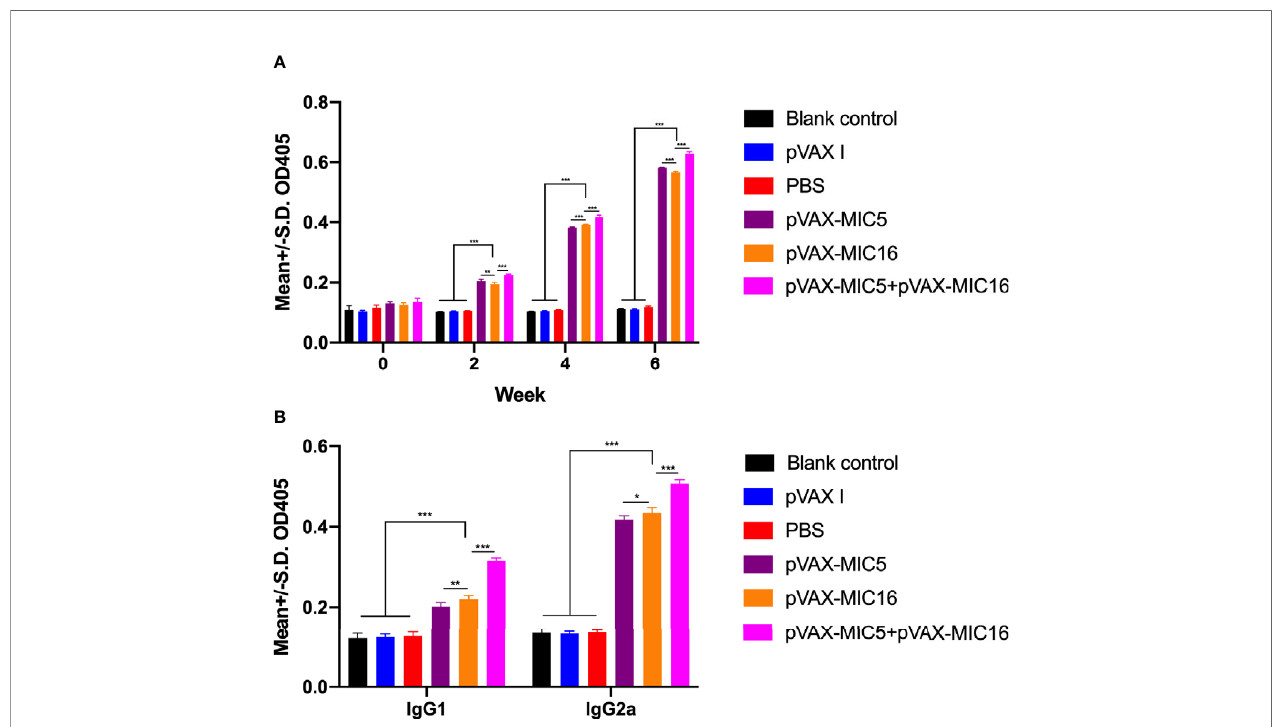
FIGURE 2 | Detection of speci fi c humoral immune responses induced by DNA immunization with single or multiple genes. (A) Determination of IgG antibodies in the sera of Kunming mice at 0, 2, 4, and 6 weeks; (B) detection of IgG1 and IgG2a antibodies in immunized mice 2 weeks after the last immunization. * P < 0.05, ** P < 0.01, *** P < 0.001. Data are presented as the means ±